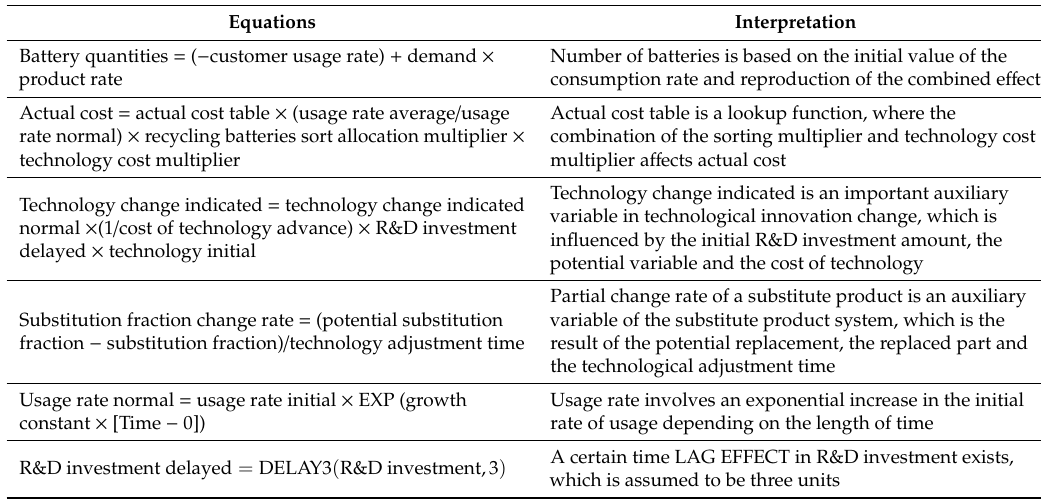
Table 1. Equations and interpretation of variables.